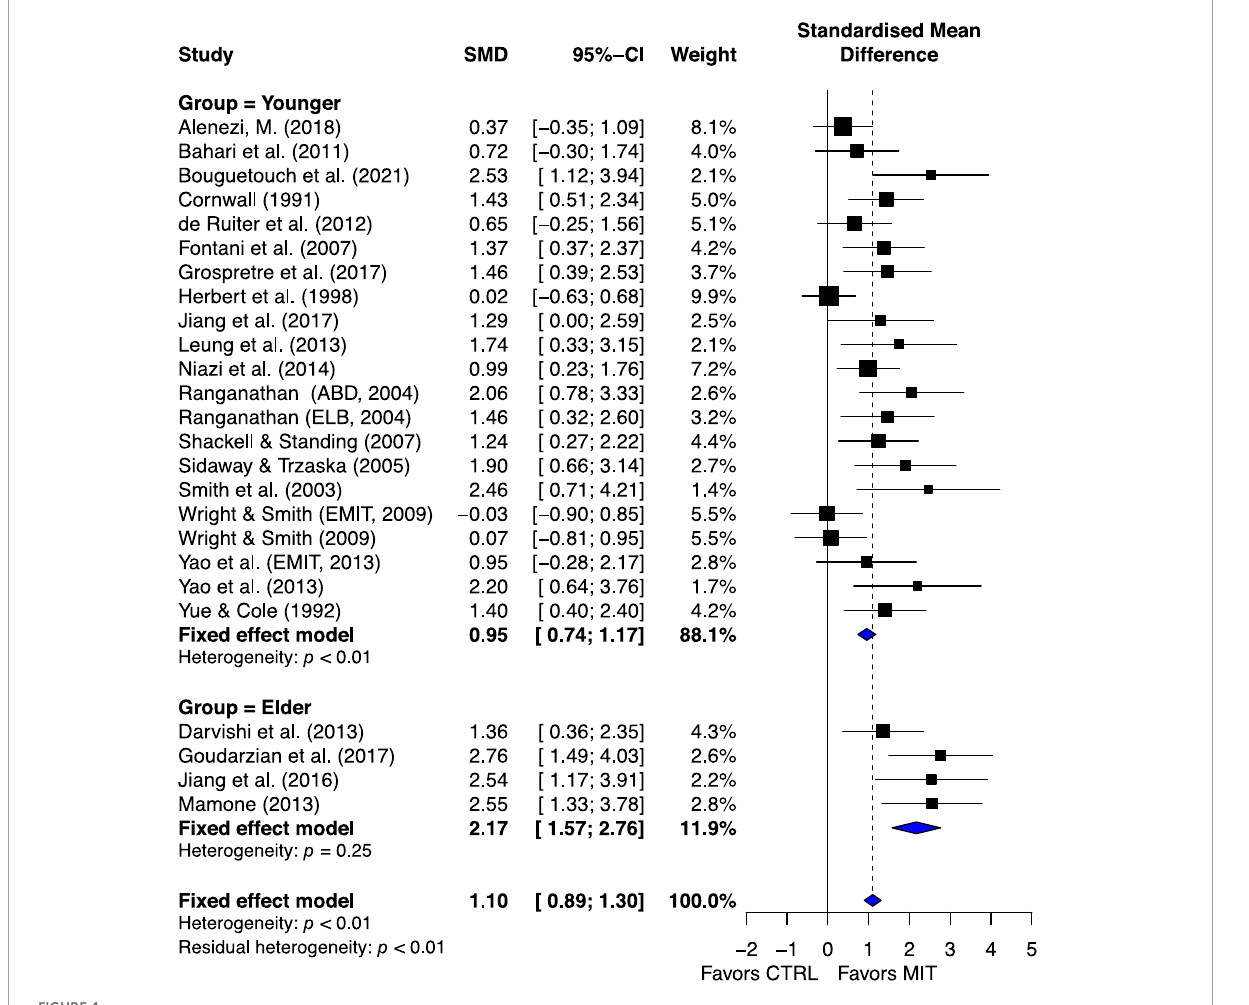
FIGURE4 Aging subgroup’s effects on maximal muscle strength: Mental imagery training (MIT) vs. control